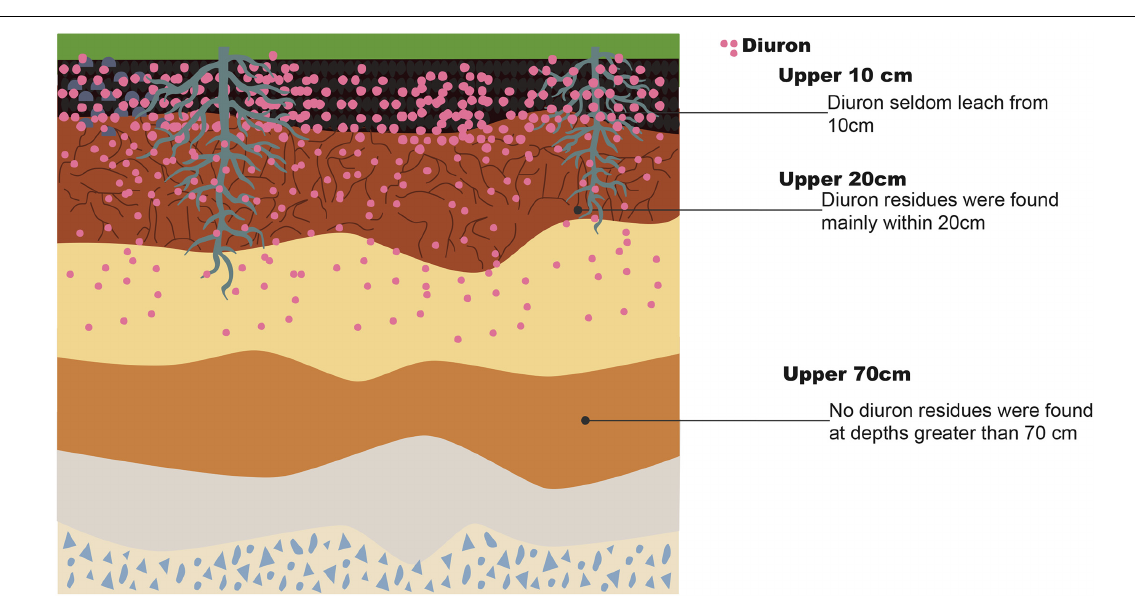
FIGURE 2 | Distribution of diuron in upper